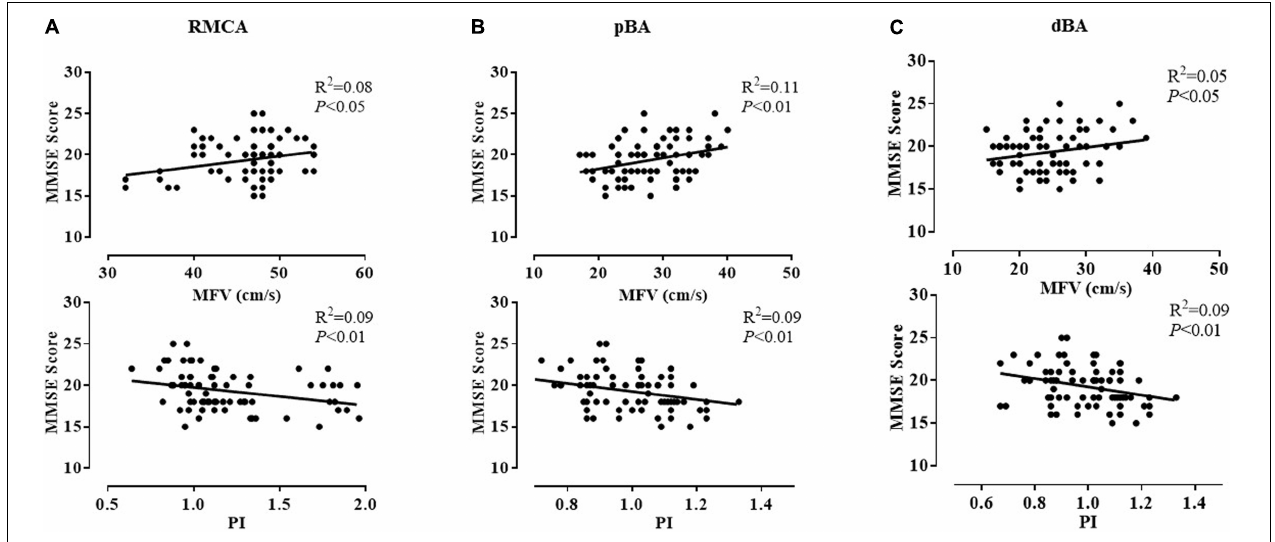
FIGURE 2 | Correlation between MMSE scores and the MFV and PI of three representative arteries in patients with dementia. After adjusting for age, sex, and vascular risk factors, the MMSE score was positively correlated with the MFV of the right MCA ( P < 0.05) (A) , pBA ( P < 0.01) (B) , and dBA ( P < 0.05) (C) and negatively correlated with the PI of the right MCA ( P < 0.01) (A) , pBA ( P < 0.01) (B) , and dBA ( P < 0.01) (C) . dBA, distal basilar artery; MCA, middle cerebral artery; MFV, mean flow velocity; MMSE, Mini-Mental State Examination; pBA, proximal basilar artery; PI, pulsatility